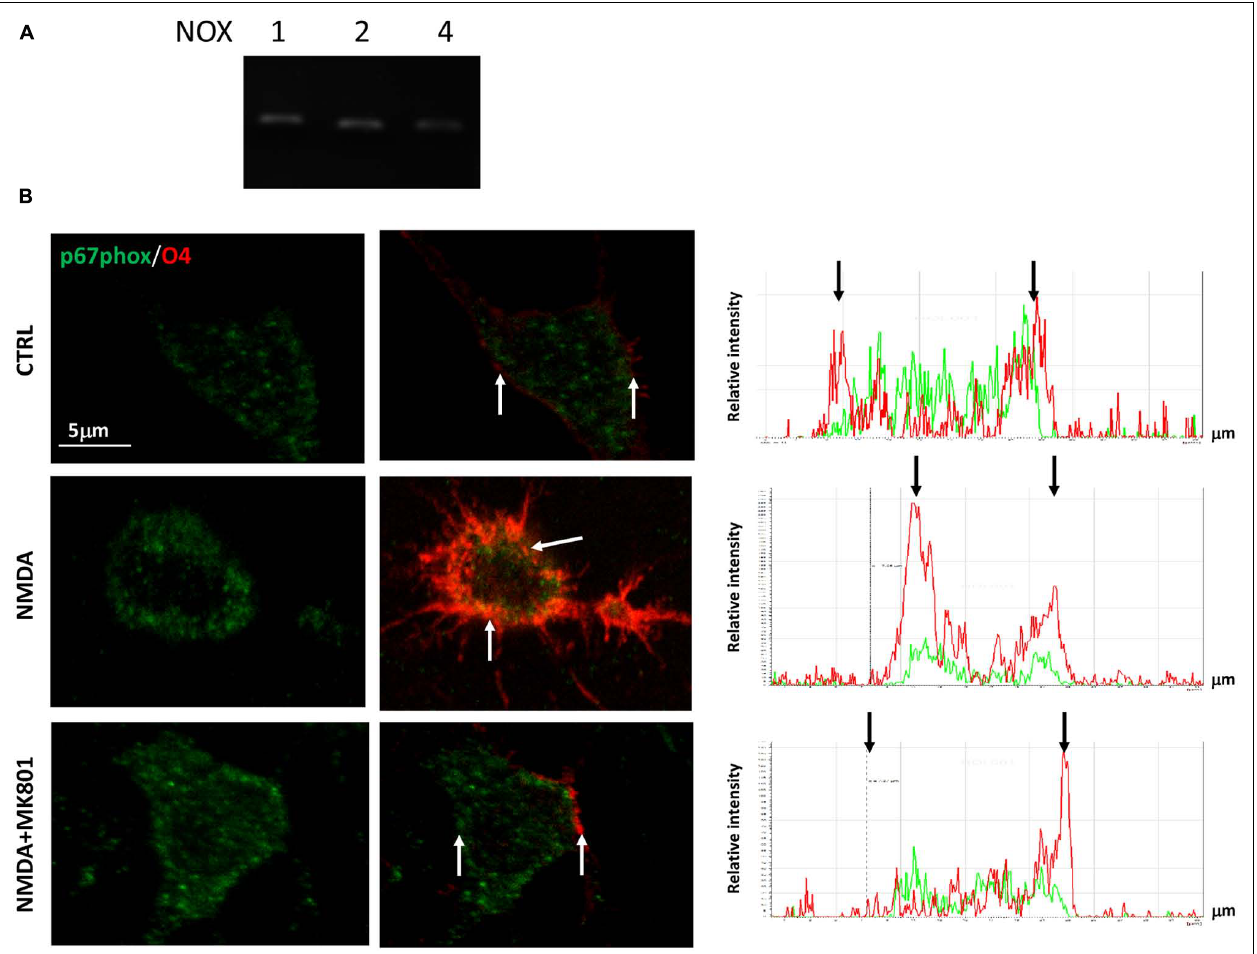
colocalization shown on the right graphs was performed by the “Linescan” application of the LAS-AF software (Leica). Red and green peaks, belonging to O4 and p67 signal respectively, colocalized only in the NMDA treated cell, whereas in CTRL and NMDA + MK801 the p67 green signal is more dispersed along the cell body (black bar). White arrows point at cellular membrane sites corresponding to black arrows on the